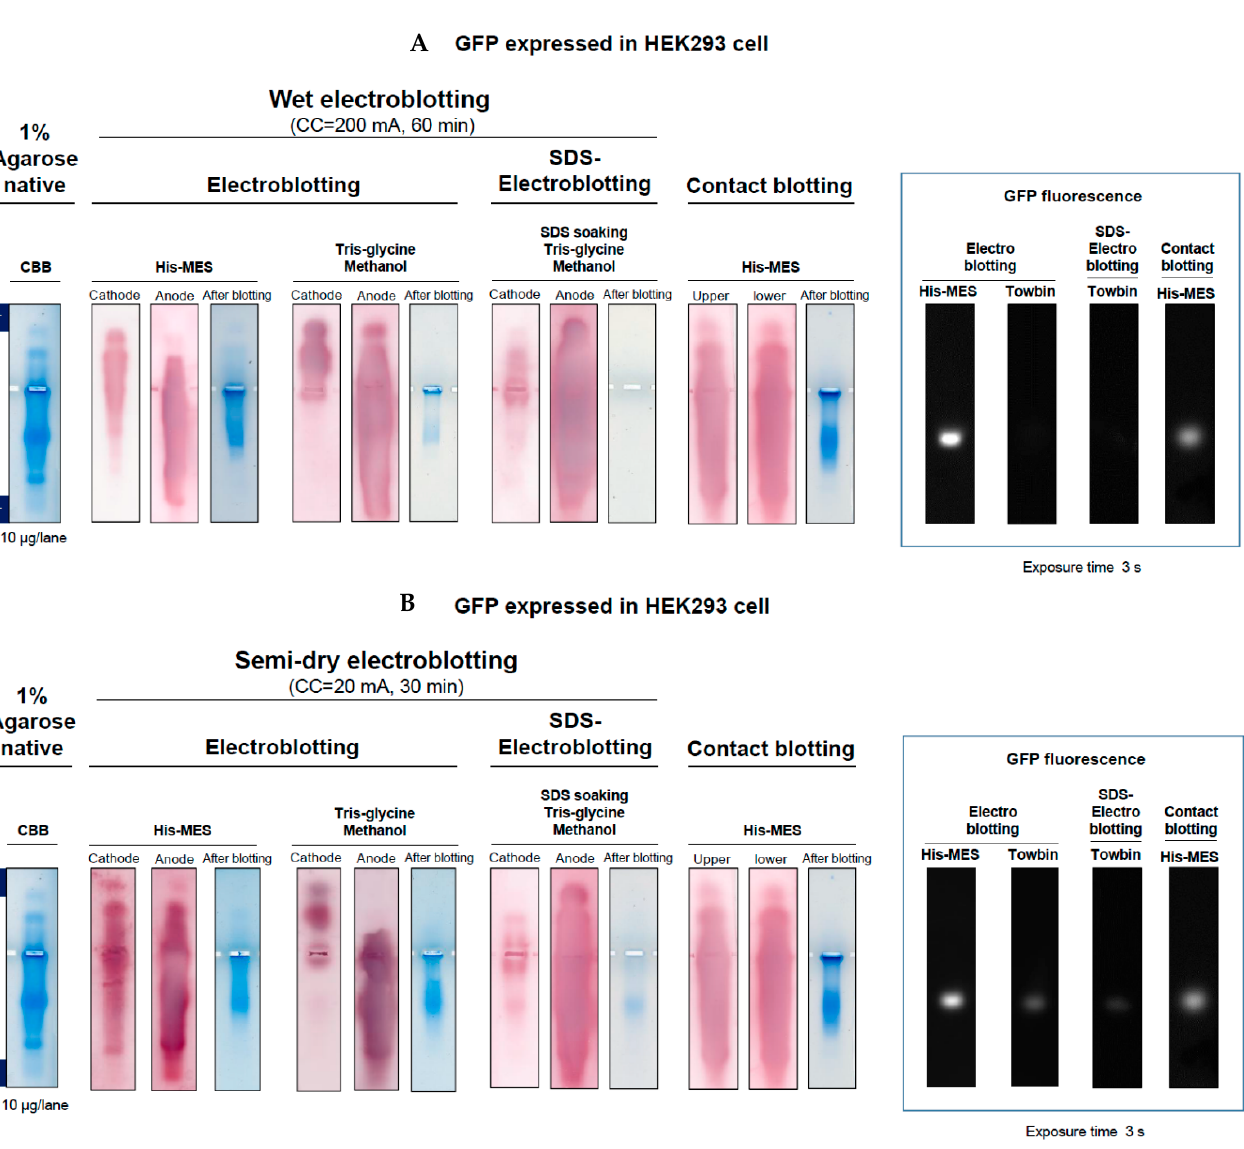
Figure 10. Comparison of electroblotting, SDS-electroblotting and contact blotting using HEK293 cell lysate expressing GFP and GFP fluorescence. ( A ) Wet blotting. ( B ) Semi-dry blotting. Transfer buffer: His/MES (pH 6.1), Tris-Glycine/Methanol (Towbin, pH 8.3). In SDS-electroblotting, agarose gels were soaked in 0.05% SDS prior to blotting in Towbin buffer. Blots were stained by Colloidal Gold Total Protein Stain. Agarose gels of pre-blot and post-blot were stained by CBB. These blots were compared for functional fluorescence state of GFP upon transfer (inset).